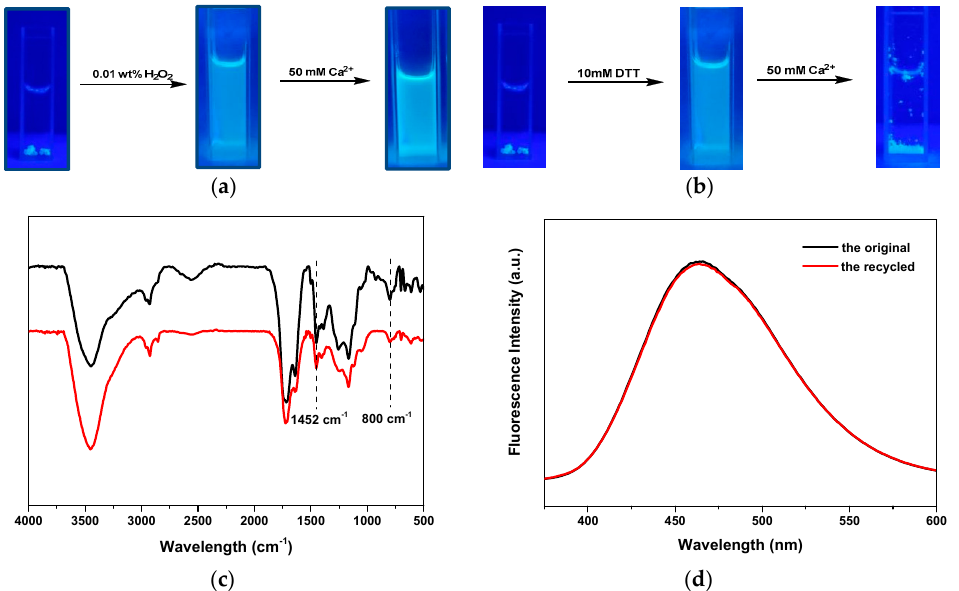
Figure 3. ( a,b ) Photographic images of SeSe 0.03 -PAA-TPE 0.02 before and after the reactions with ( a ) 0.01 wt.% H 2 O 2 or ( b ) 10 mM DTT and the additions of Ca 2+ under a UV lamp (365 nm); ( c ) FT-IR spectra of SeSe 0.03 -PAA-TPE 0.02 before (black) and after (red) the recovery; ( d ) fluorescence intensities in the reaction solution of SeSe 0.03 -PAA-TPE 0.02 before and after the recovery, post-reduction with 10 mM DTT ( λ Ex = 340 nm, slit width for Ex. and Em. = 5.0, PMT =